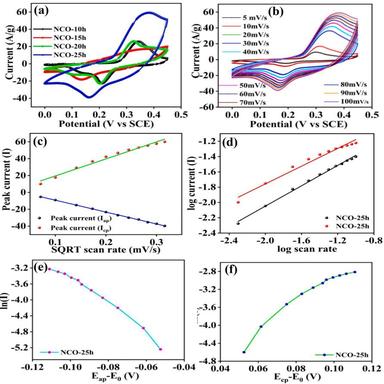
(a) CV curves for all four NCO samples at 10 mVs− 1 , and for the representative NCO-25 sample (b) CV cures at different scan rates, (c) anodic and cathodic peak current versus square root of scan rate for diffusion constant, (d) log (current) as a function of log (scan rate) for b-value, (e,f) log (current) as a function of (Ep-E0 ) for transfer coefficient and standard rate constant.